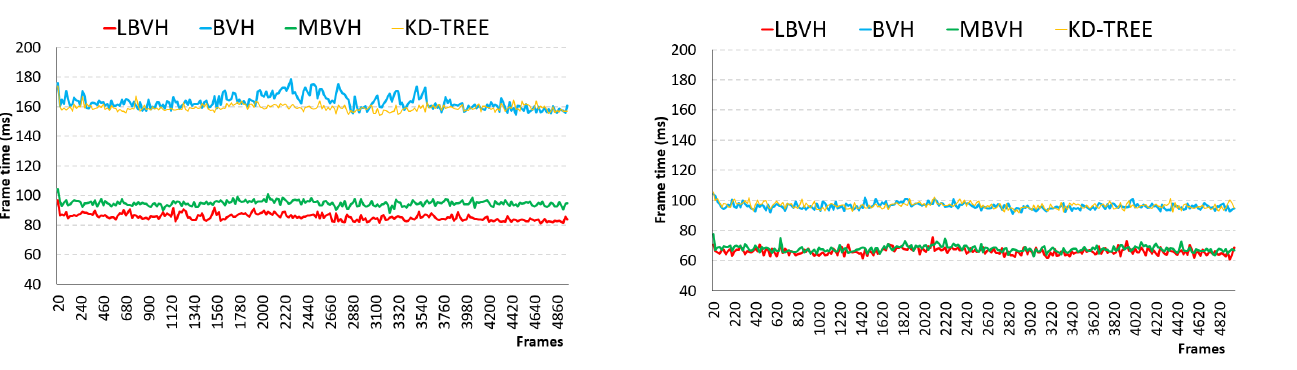
Fig. 7. Comparison of different acceleration data structures for reflections of static models and two deformable T-Rex dinosaurs, in the walkthrough animation.